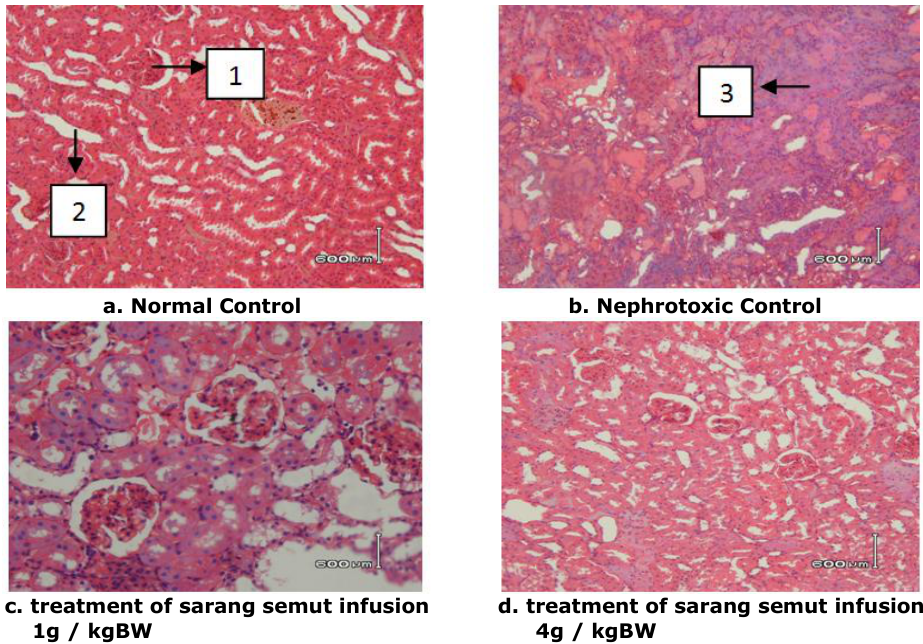
Figure 4. Kidney’s histology with hematoxilin and Eosin staining. (1) normal glomeruli, (2) normal tubuli, (3) nephrosis (indicated by eosinophilic homogeneous mass in the lumen of the tubular part, partly tubular epithelial degeneration and